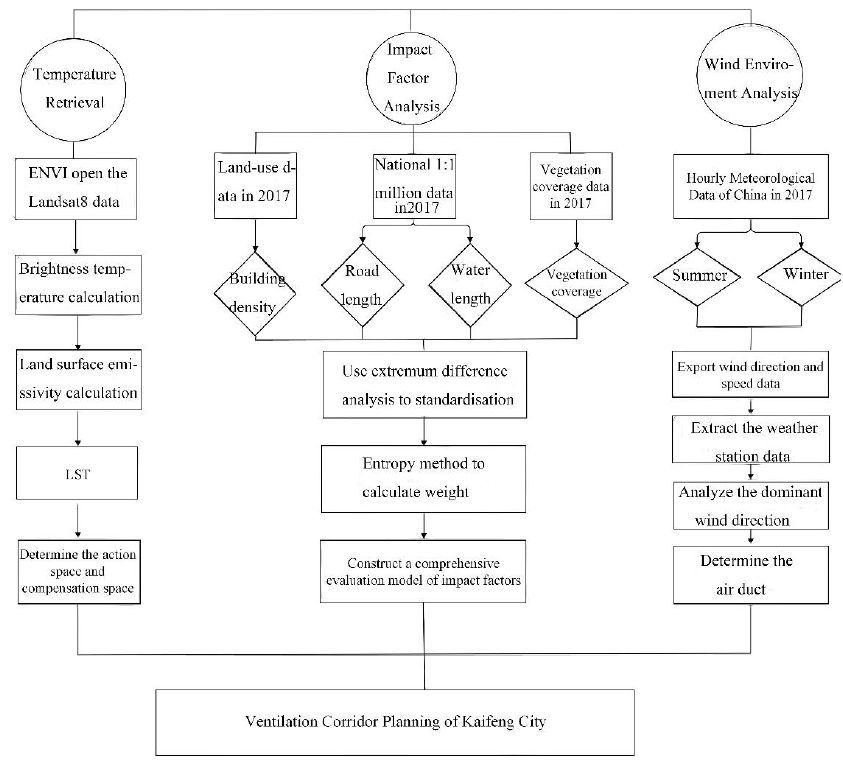
Figure 2. Framework of this study.